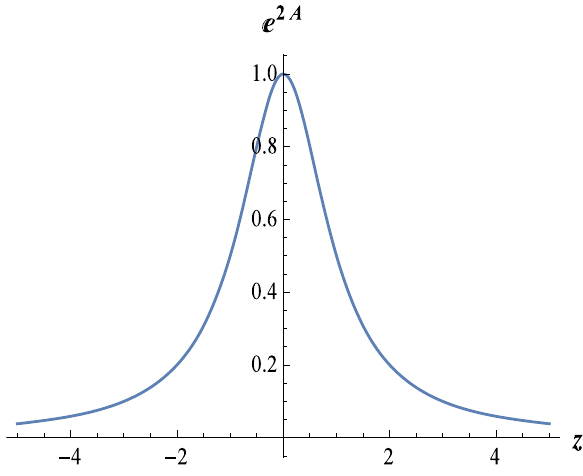
Fig. 1 The shape of the warp factor e 2 A ( z ) in the coordinate z . The parameters are set to a = 1 and b = 1